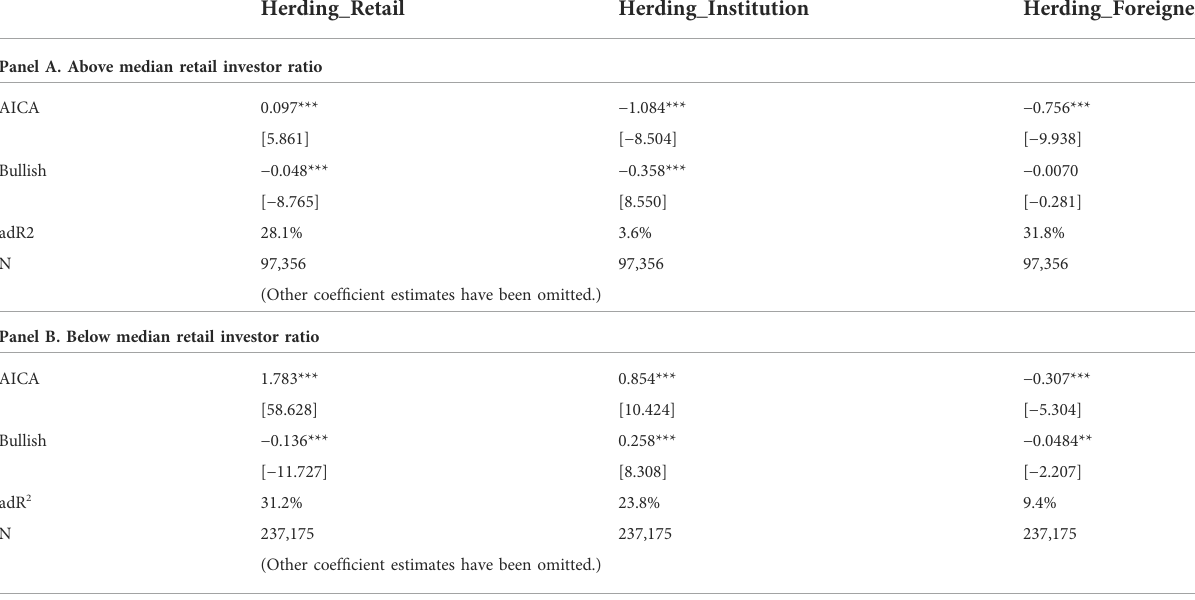
TABLE 6 Robustnesstests of retail investor ratio groups. Table reportsimpact ofkey variables on herding separated into different retail investor ratio groups. This table presents the parameter in Eq. 6. Regression analysis is performed by dividing into two groups, above and below median retail investorratiounderlyingtradingvolume.AICAistheabnormalICA.Bullishisaninvestmentsentimentindicatorthatrepresentstheopinionscore.For brevity, We only show the results of the main variables in the table and the coef fi cient estimates of controlled variables are suppressed.